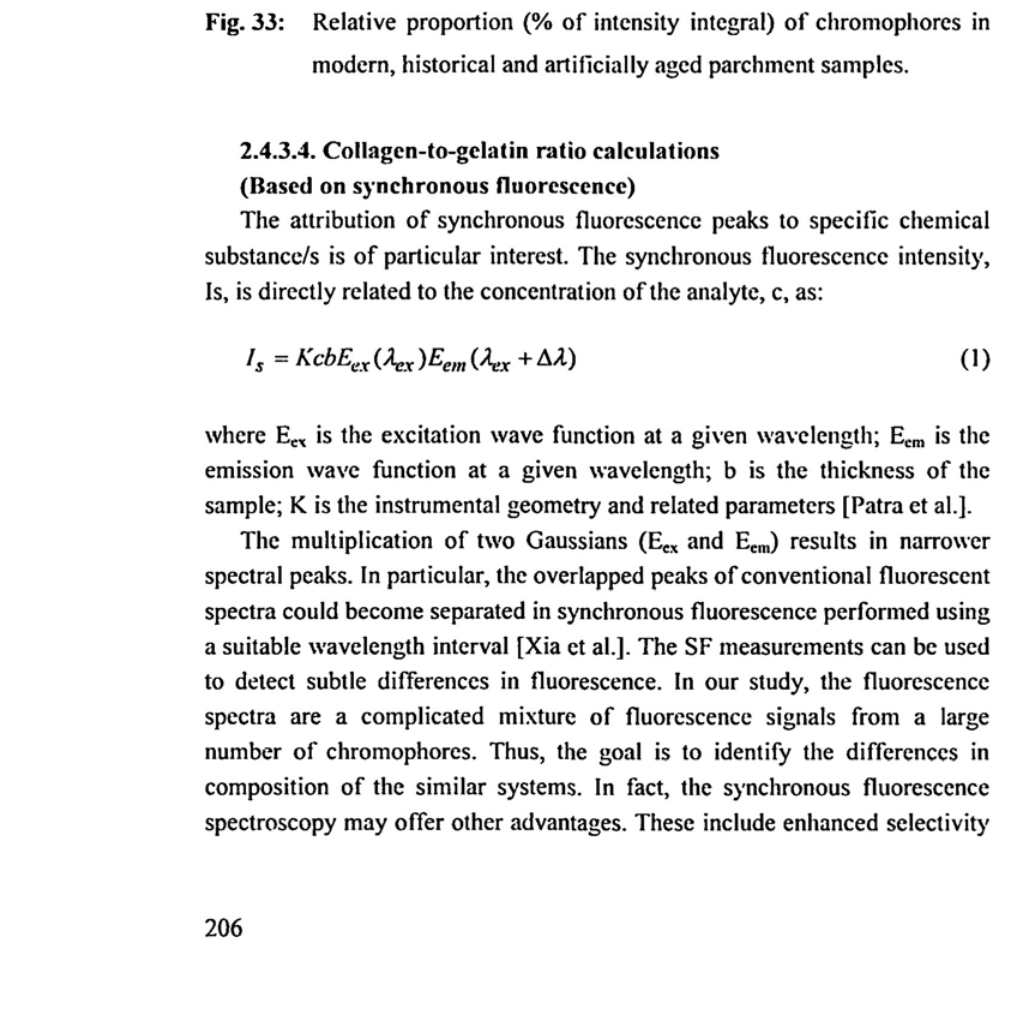
Fig. 33: Relative proportion (% of intensity integral) of chromophores in modern, historical and artificially aged parchment